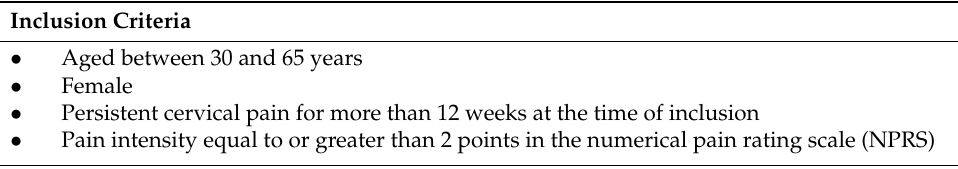
Table 1. Inclusion, exclusion, and withdrawal